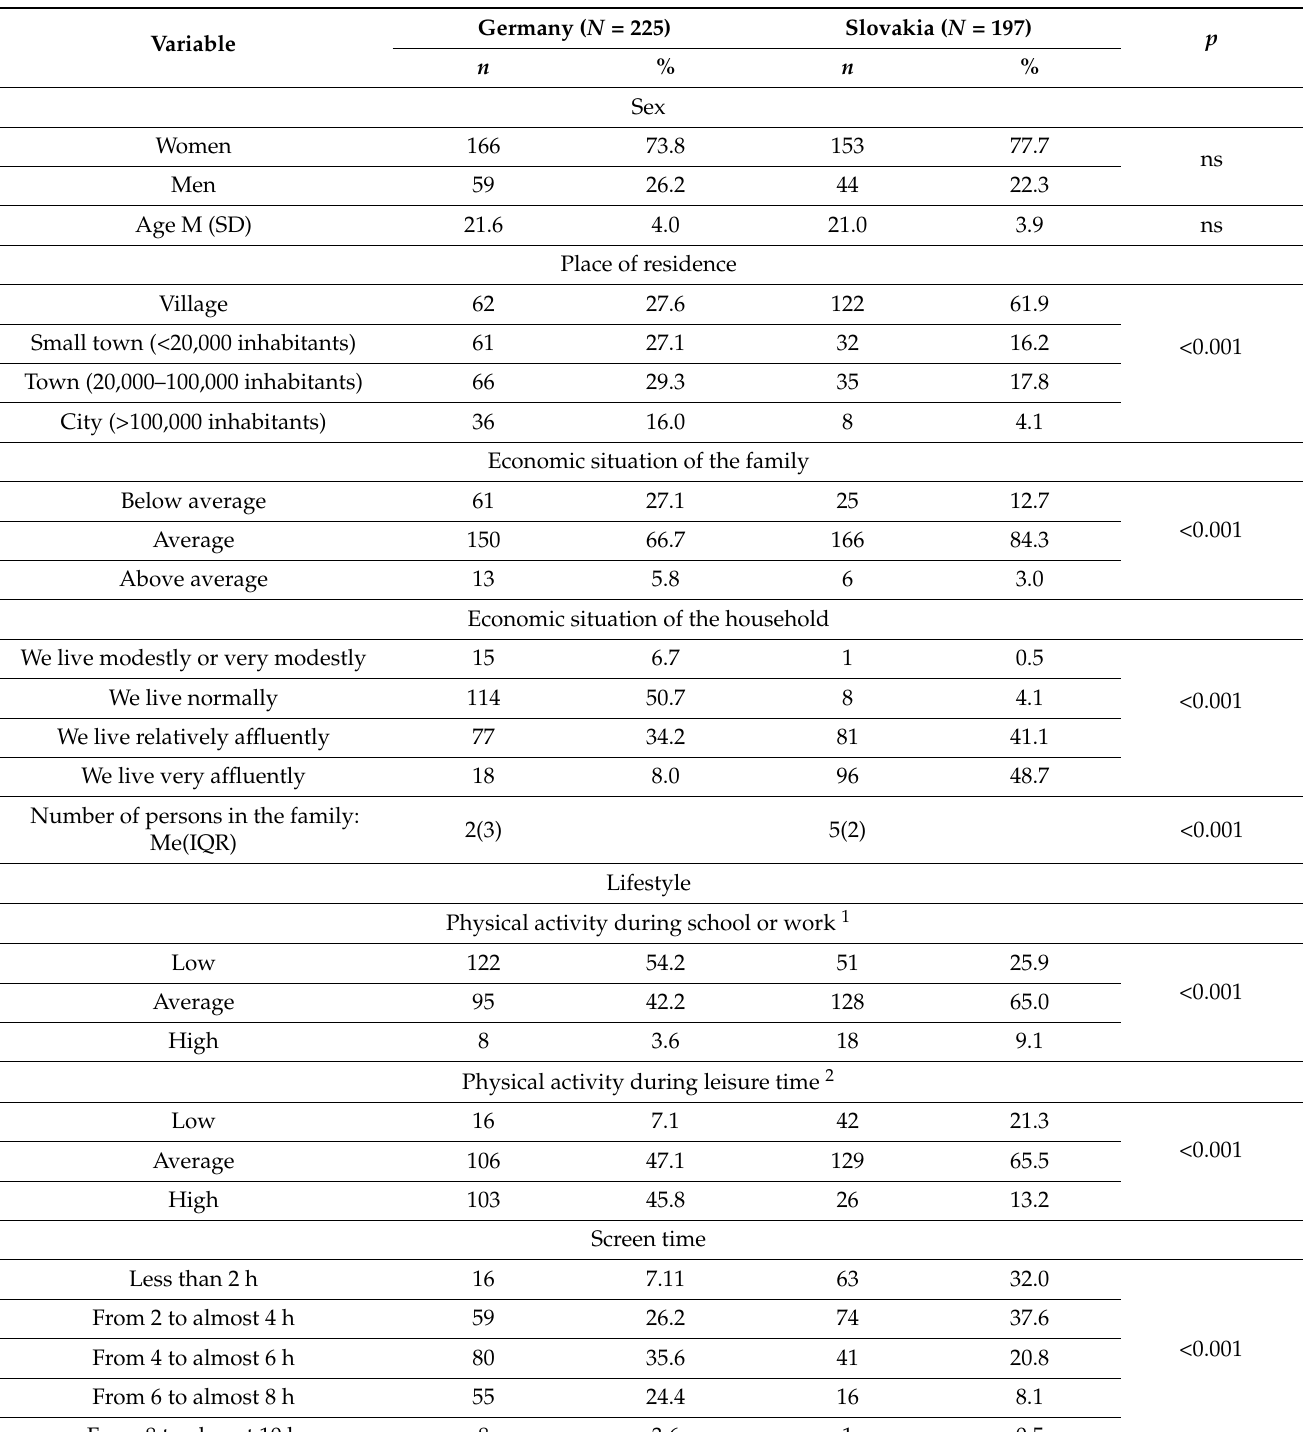
Table 1. Characteristics of the study